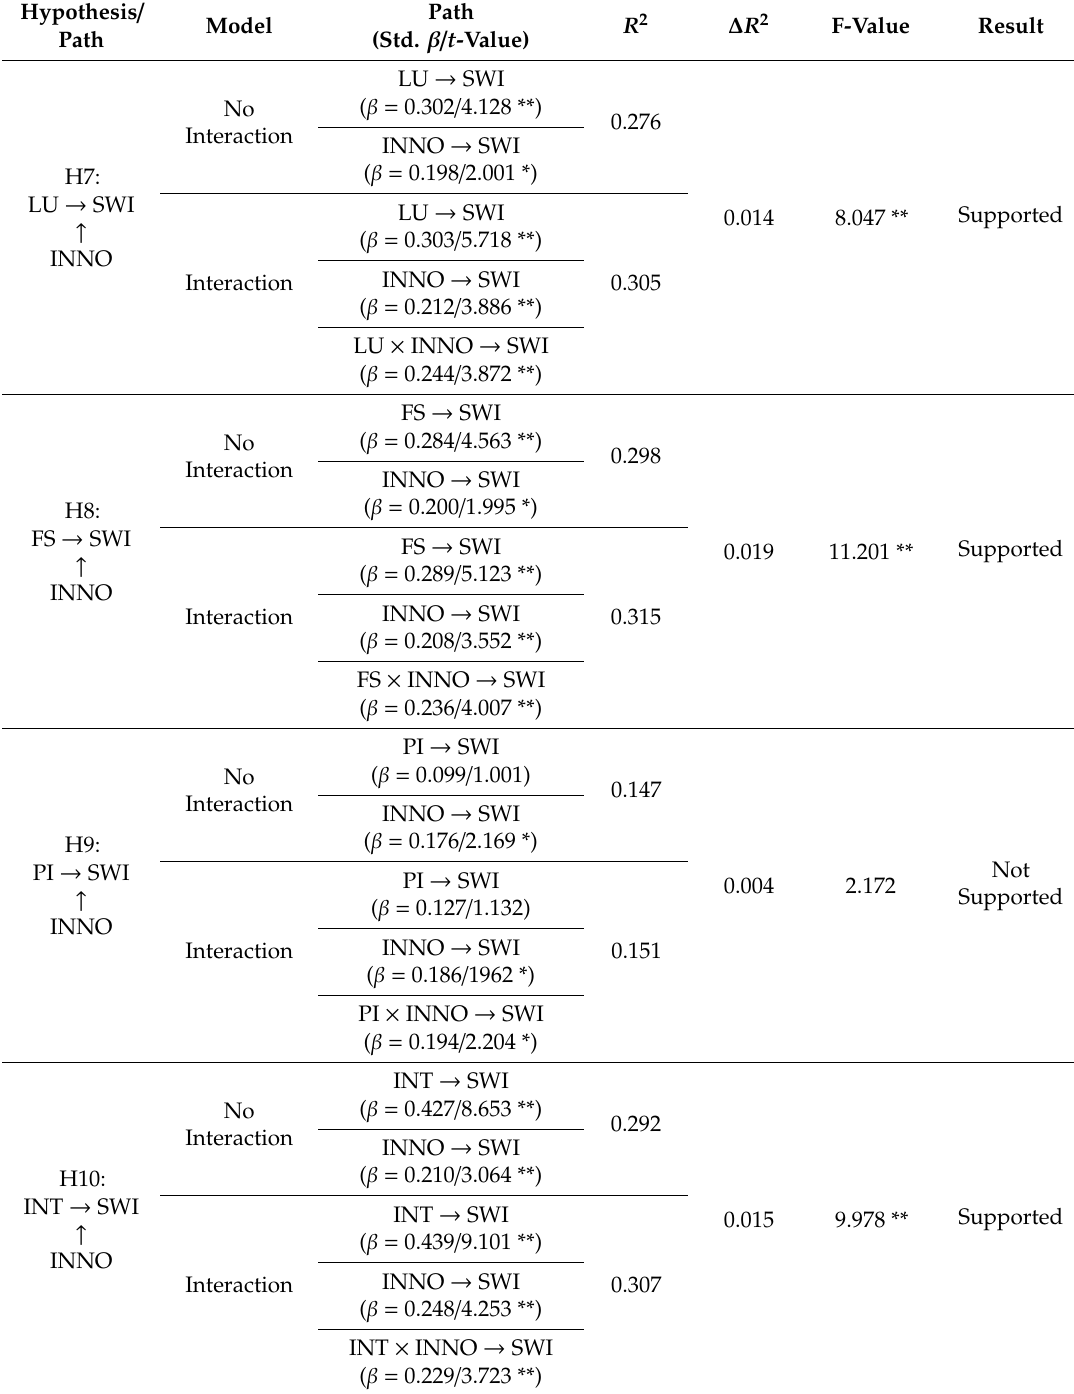
Table 7. Summary of moderating e ff ect tests